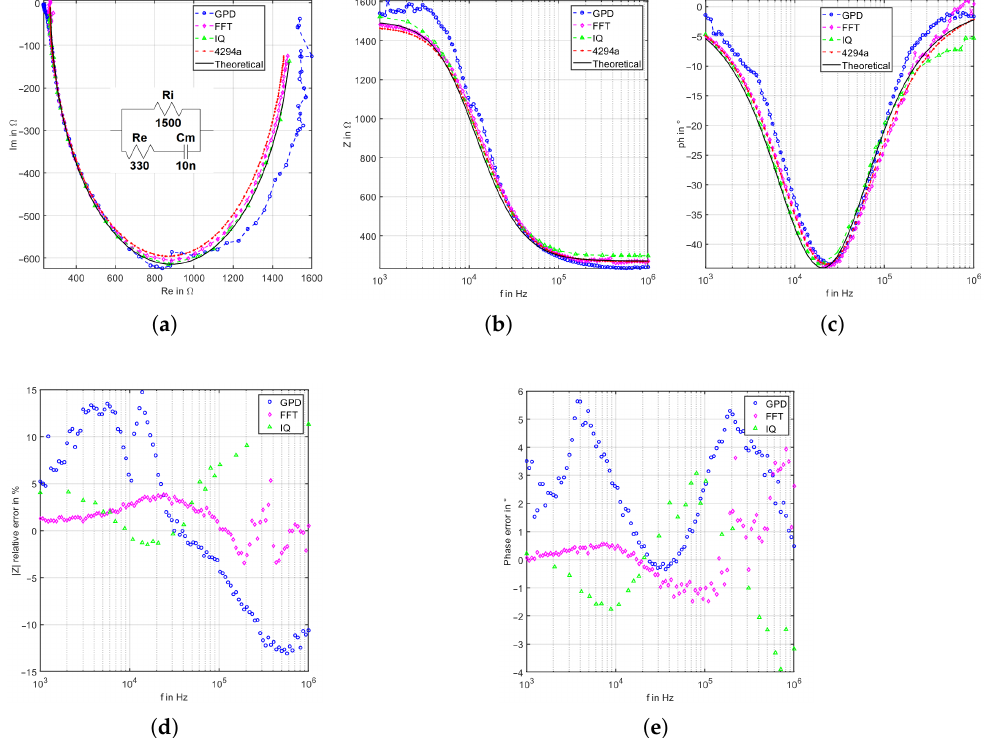
Figure 11. Evaluation of Cole–Cole model 2 using 1.5 k Ω parallel to 330 Ω resistor in series to 10 nF. ( a ) Nyquist plot, ( b ) magnitude bode plot, ( c ) phase bode plot, ( d ) magnitude relative deviation, and ( e ) phase relative